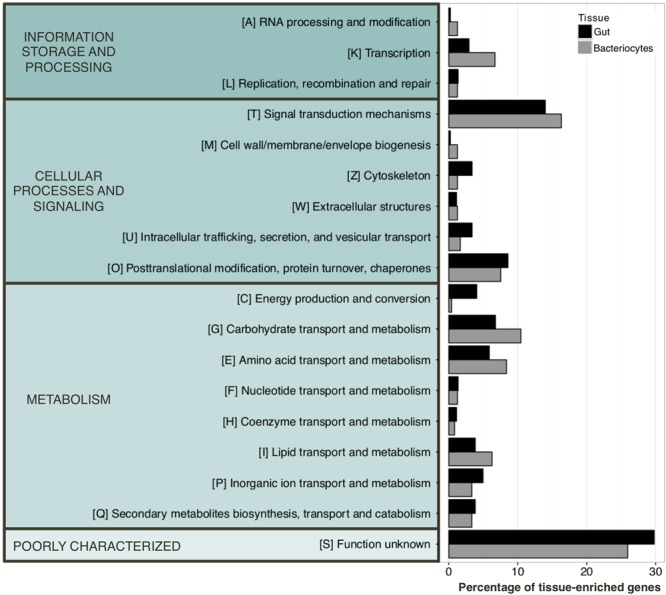
eggNOG classification of the tissue-enriched genes. Genes were defined as being tissue-enriched using a fourfold change threshold in the gut/bacteriocyte contrast. 1 079 and 638 genes were categorized as tissue specific in aphid gut and bacteriocytes, respectively.